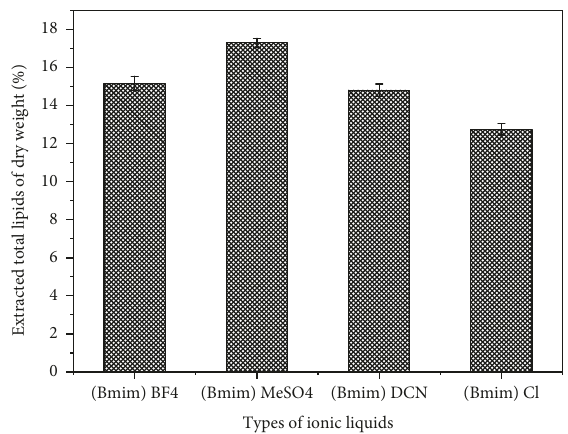
Figure 1: The in fl uence of types of ionic liquids on lipid extraction.